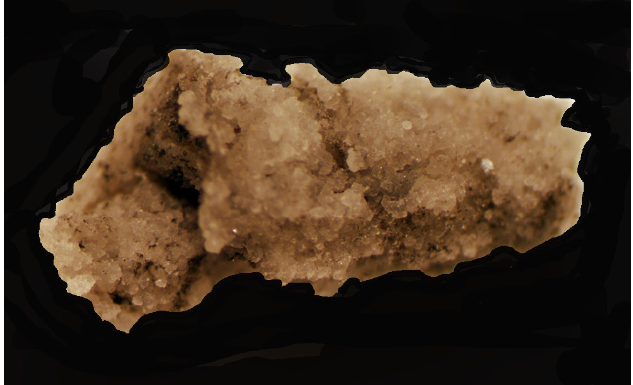
Figure 10. Abyssochrysoid gastropod (IGM 5010b). Note polygonal aperture and the last whorl separating slightly from the previous whorl, forming a channel.